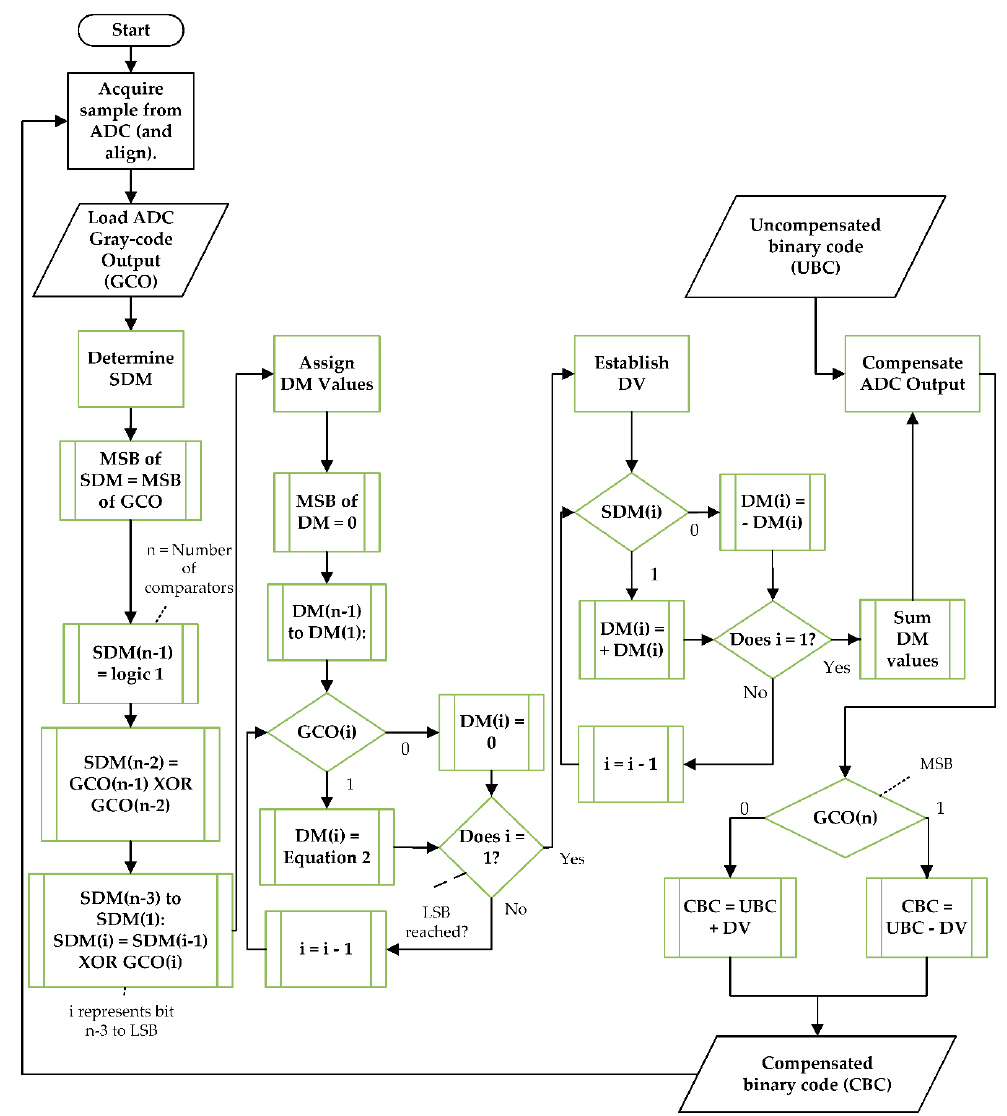
Figure 6. A more detailed flowchart of the algorithm.